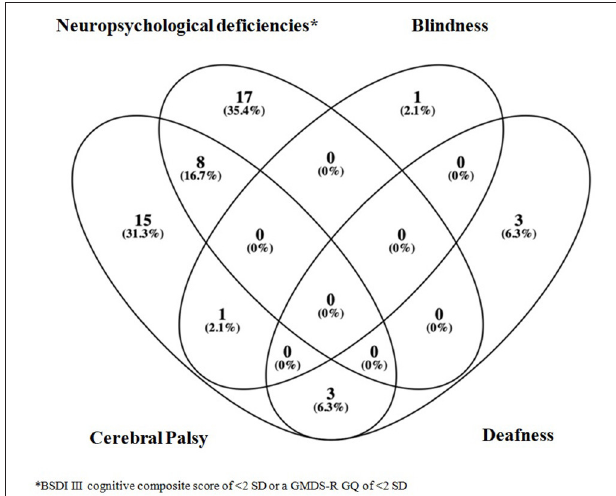
FIGURE 3 | Severe functional disability Venn